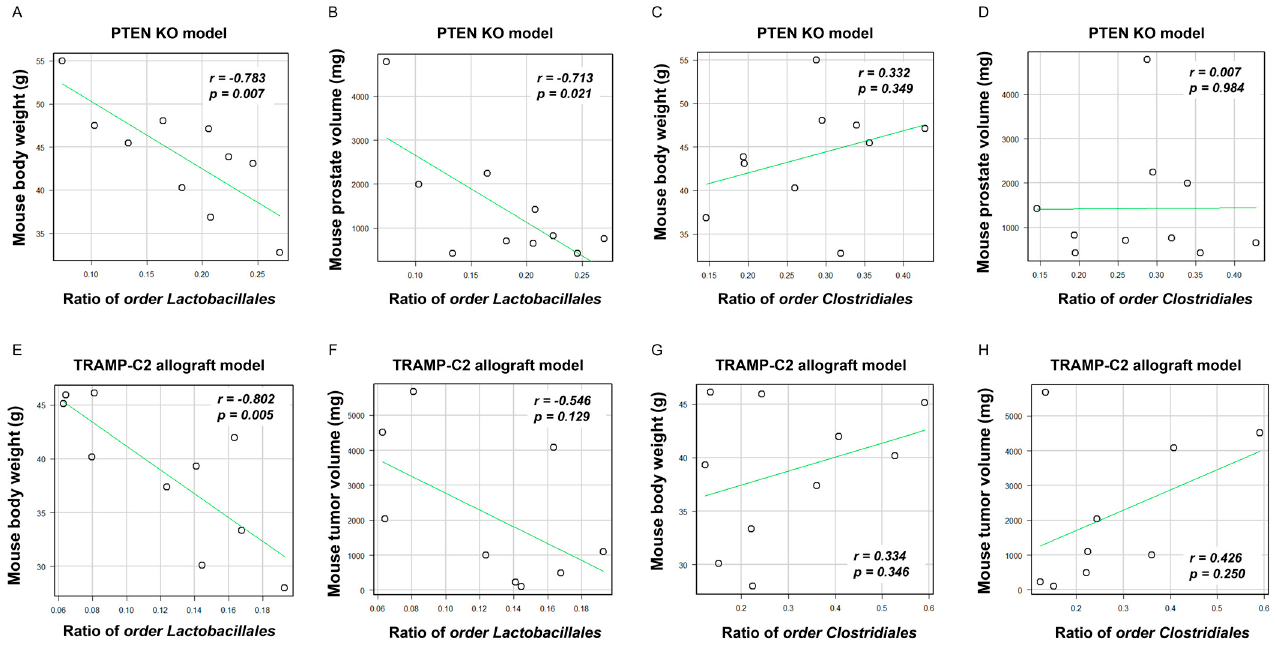
Figure 4. Correlation between the proportion of two specific microbiotas, body weight, prostate weight, and tumor volume. The dots in each scatter plot indicate the values of each sample. ( A ) Correlation between the body weight of mice and the rate of the order Lactobacillales in the Pten KO model. ( B ) Correlation between the prostate volume of mice and the rate of the order Lactobacillales in the Pten KO model. ( C ) Correlation between the body weight of mice and the rate of the order Clostridiales in the Pten model. ( D ) Correlation between the prostate volume of mice and the rate of the order Clostridiales in the Pten KO model. ( E ) Correlation between the body weight of mice and the rate of the order Lactobacillales in the TRAMP-C2 allograft model. ( F ) Correlation between the subcutaneous tumor of mice and the rate of the order Lactobacillales in the TRAMP-C2 allograft model. ( G ) Correlation between the body weight of mice and the rate of the order Clostridiales in the TRAMP-C2 allograft model. ( H ) Correlation between the subcutaneous tumor of mice and the rate of the order Clostridiales in the TRAMP-C2 allograft model.